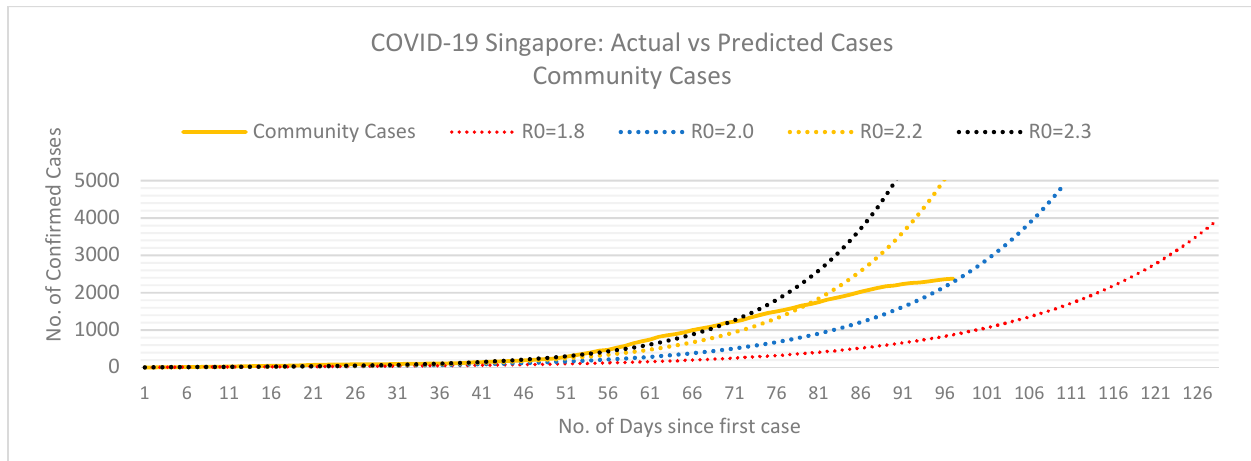
Figure 3. Exponential growth of COVID-19 in Singapore of Migrant Workers living in Dormitories. Dotted lines represent differing COVID-19 basic reproduction numbers ( R 0). Data retrieved from the Singapore Ministry of Health and the WHO [68,69]. Last updated on 2 May 2020.